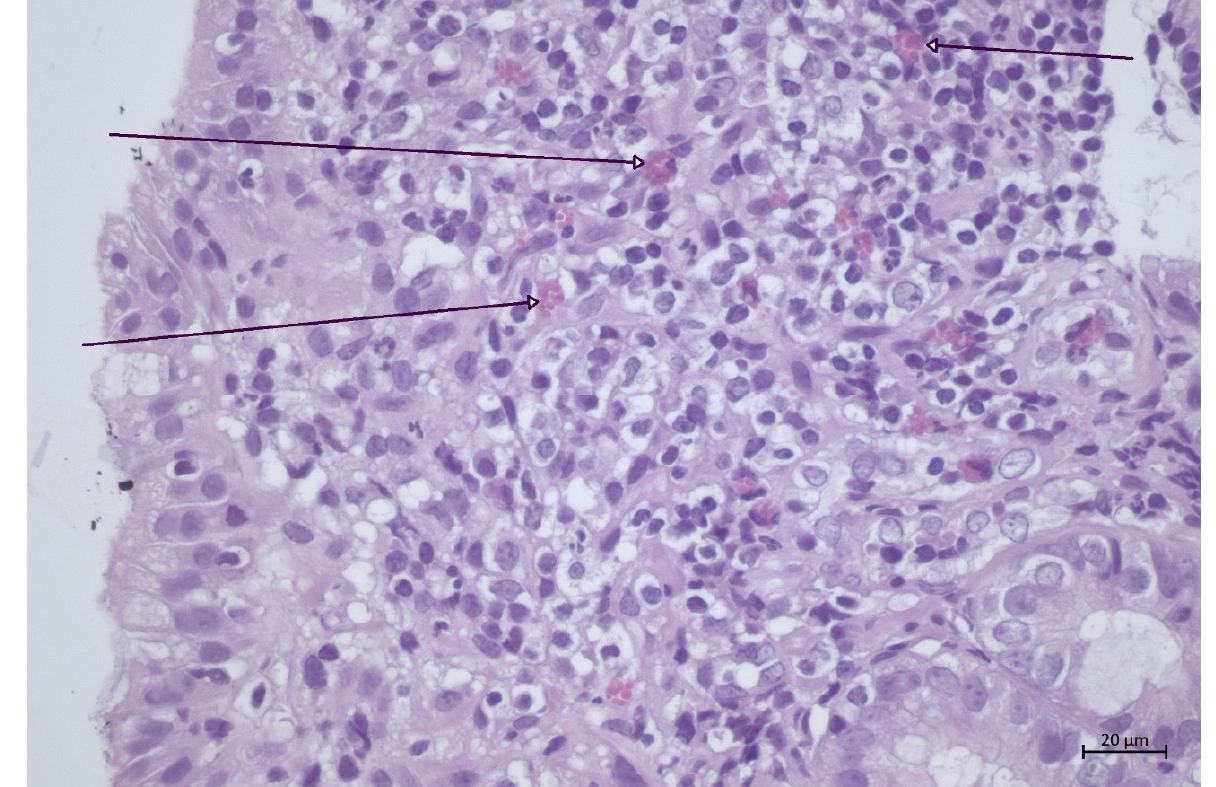
Figure 5. Histopathological image of a horse diagnosed with moderate subacute to chronic non- ulcerative duodenitis. Mott’s cells are marked with an arrow. Magnification 600×.